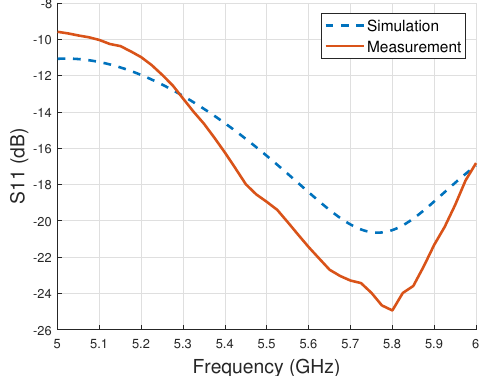
Figure 4. Return loss, simulation vs. measurement.